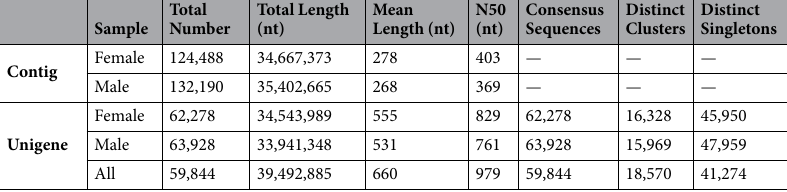
Table 1. Summary of the Pluttela xylostella transcriptome